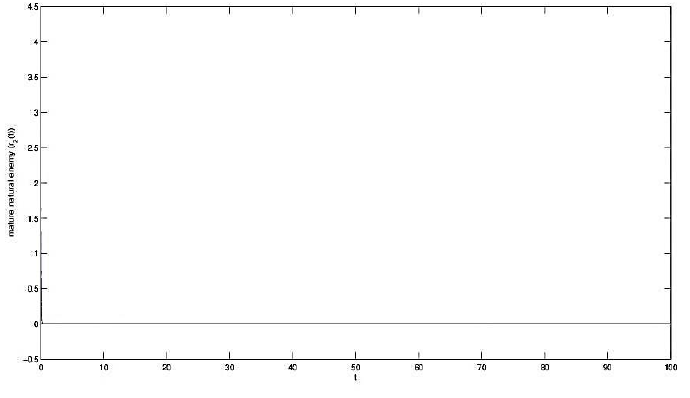
Figure 12. Mature natural enemy (𝑟